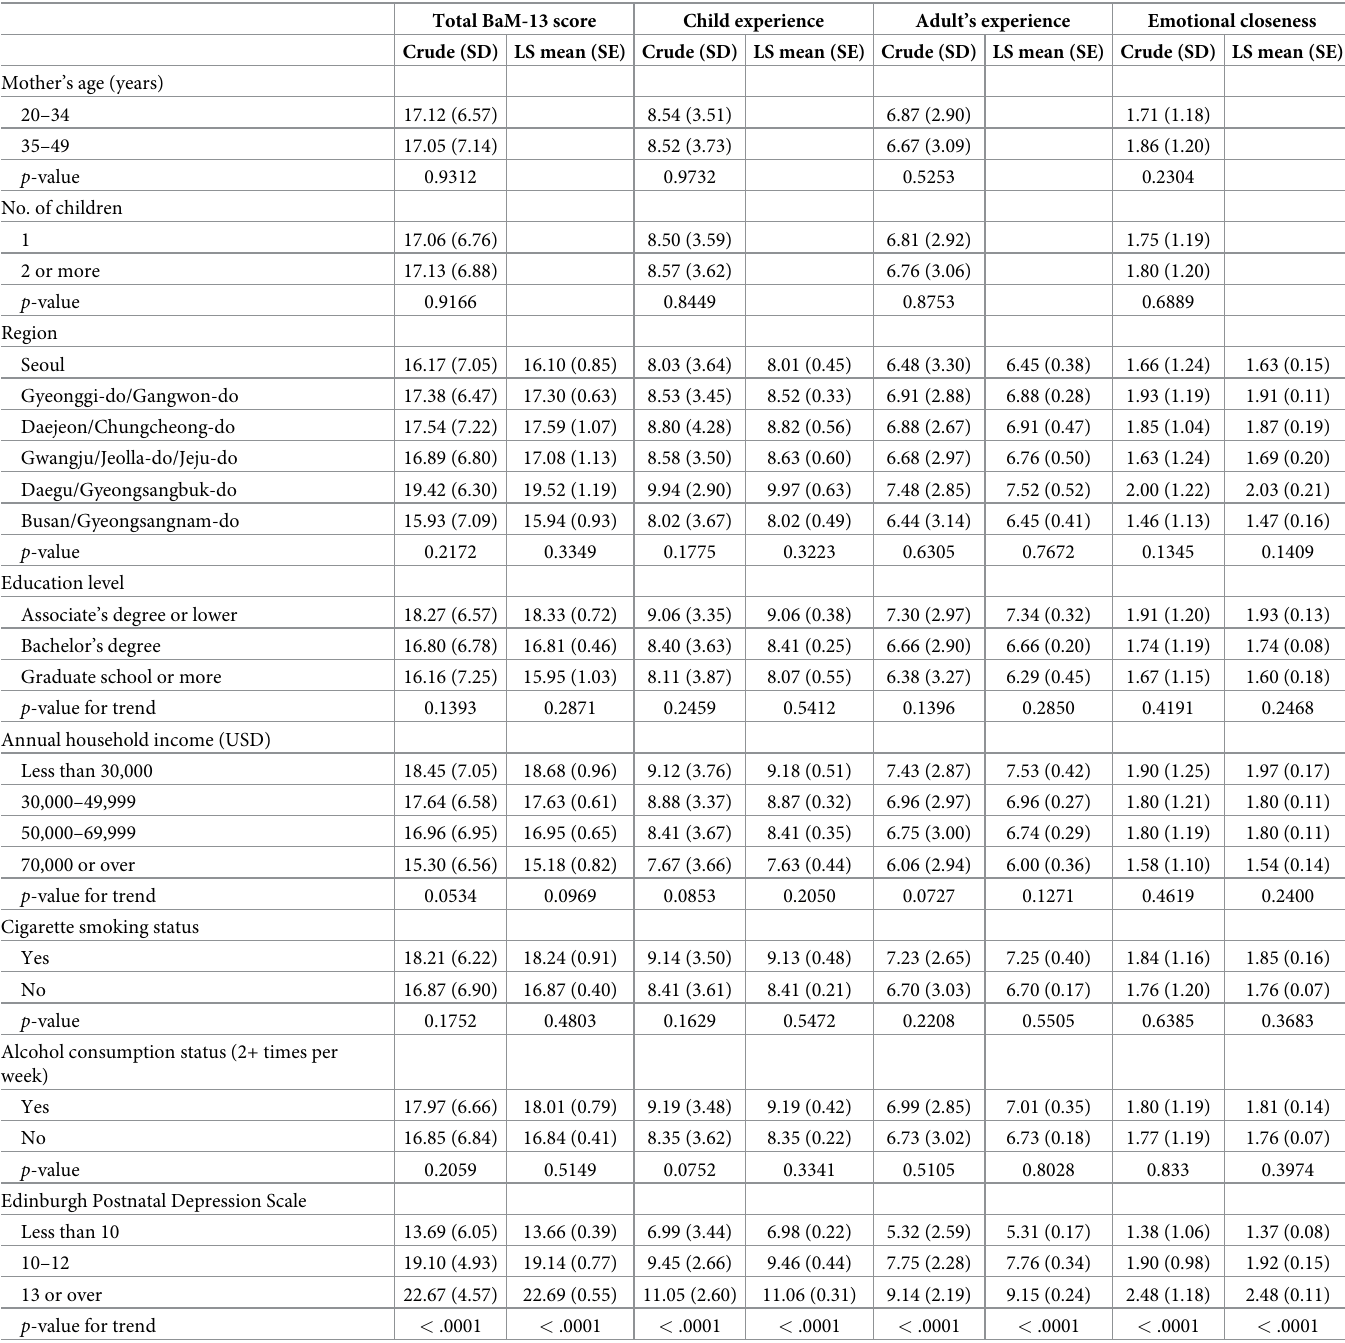
Table 3. Crude and women’s age- and parity-adjusted least-square mean scores (95% confidence intervals) by three factors of